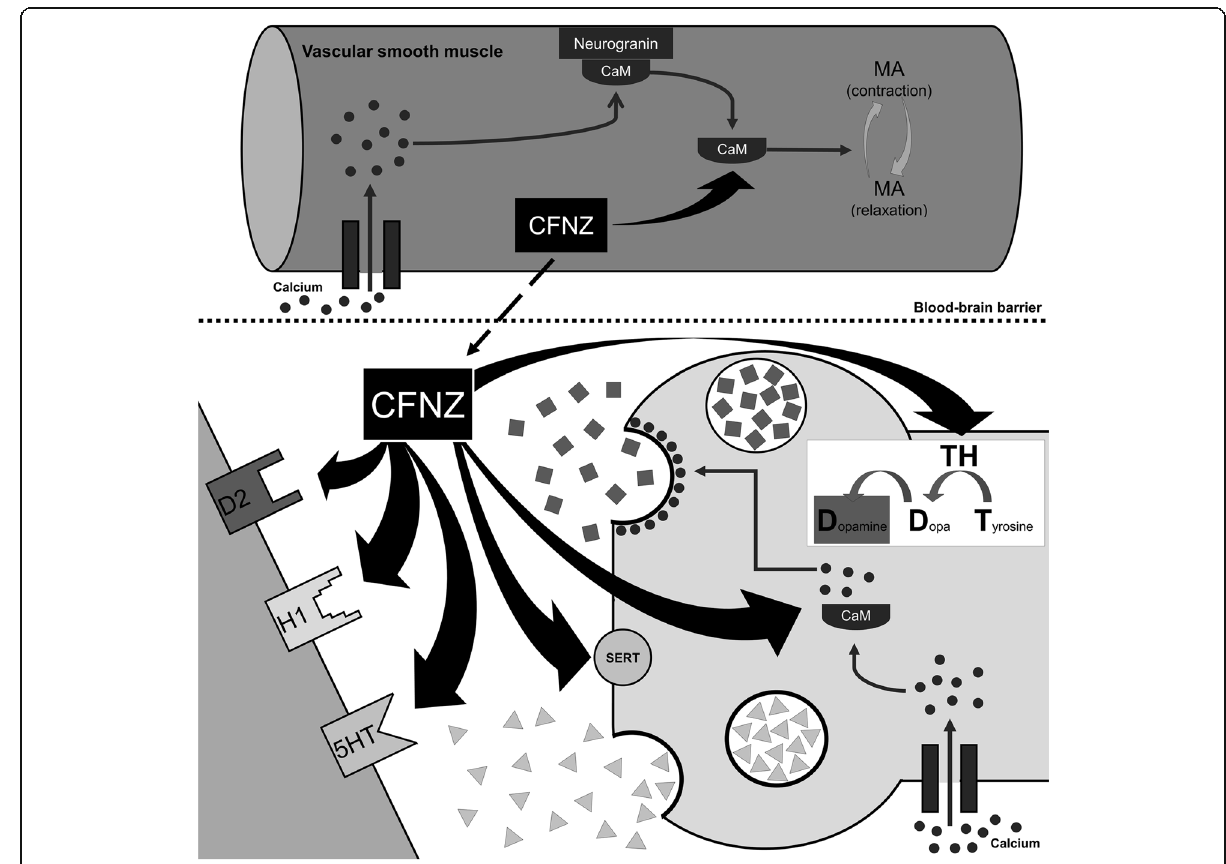
Fig. 2 Schematic diagram of the mechanism of action of cinnarizine and flunarizine (CFNZ). CFNZ can act in the vascular smooth muscle blocking the complex calcium-calmodulin (CaM), which will inhibit muscle contraction. In the central nervous system, CFNZ has six main actions; blockage of dopamine D2, histamine H1, and serotonin receptors. Also, it can inhibit the tyrosine hydroxylase and CaM decreasing the synthesis and release of dopamine. Moreover, depending on the site of action, CFNZ can increase serotonin concentration inhibiting serotonin reuptake (SERT) and facilitating serotonin